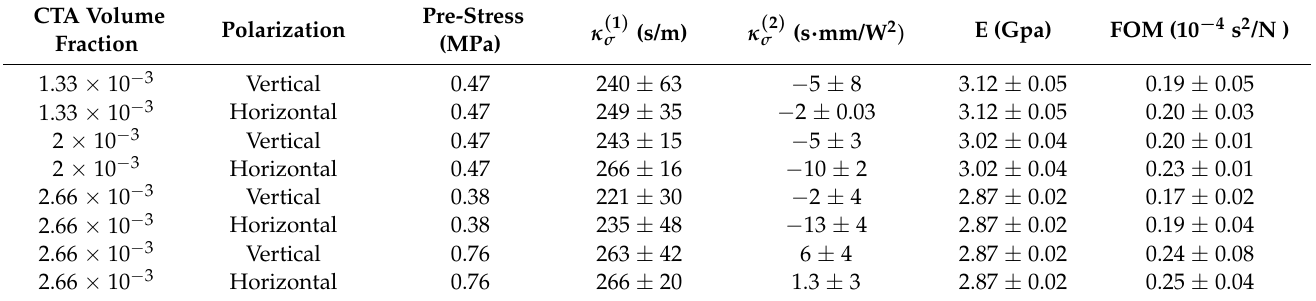
Table 3. Summary of the room-temperature properties of Disperse Red 1 doped poly (methyl methacrylate) (DR1-doped PMMA) fibers as a function of CTA volume fraction, pre-stress and light polarization at a pump wavelength of 488nm.